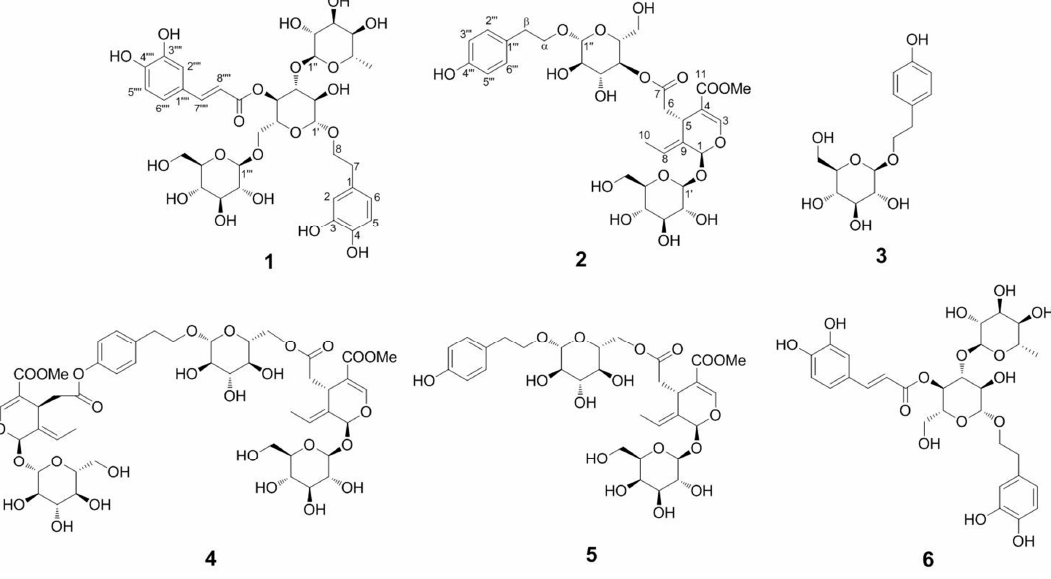
Figure 1. Chemical structures of compounds 1 – 6 .